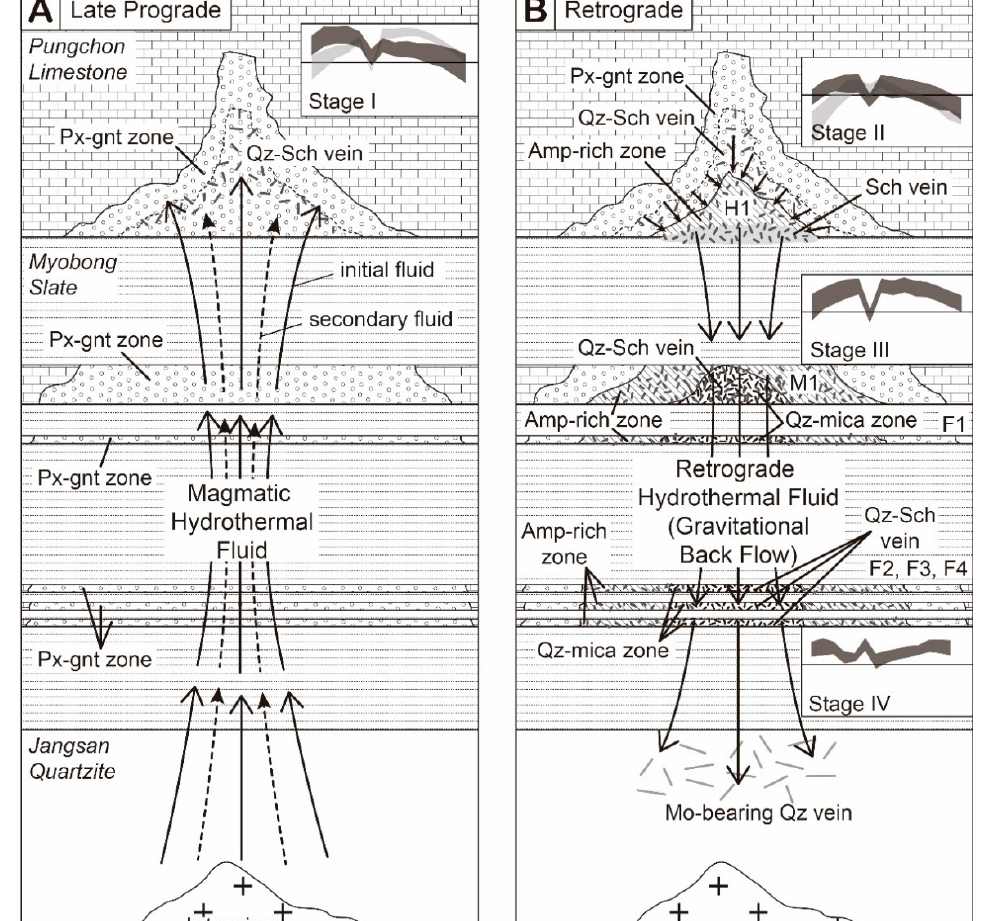
Figure 11. Schematic diagram of scheelite mineralization at the quartz–scheelite vein system of the Sangdong W-deposit. ( A ) Initial magmatic–hydrothermal fluid releases from the granitic body and forms prograde skarn. Secondary fluid of the late prograde stage forms magmatic stock, slowly filling the fractures, and forms stage I scheelite of quartz–scheelite veins. ( B ) Retrograde hydrothermal fluid migrates through pressure release and gravitational back flow mechanism through fractures. As W in the mineralizing fluid is consumed gradually, stage II to IV scheelites form through fractional crystallization. Final stage of reduced condition and W-poor fluid forms quartz–molybdenite vein of Jangsan quartzite